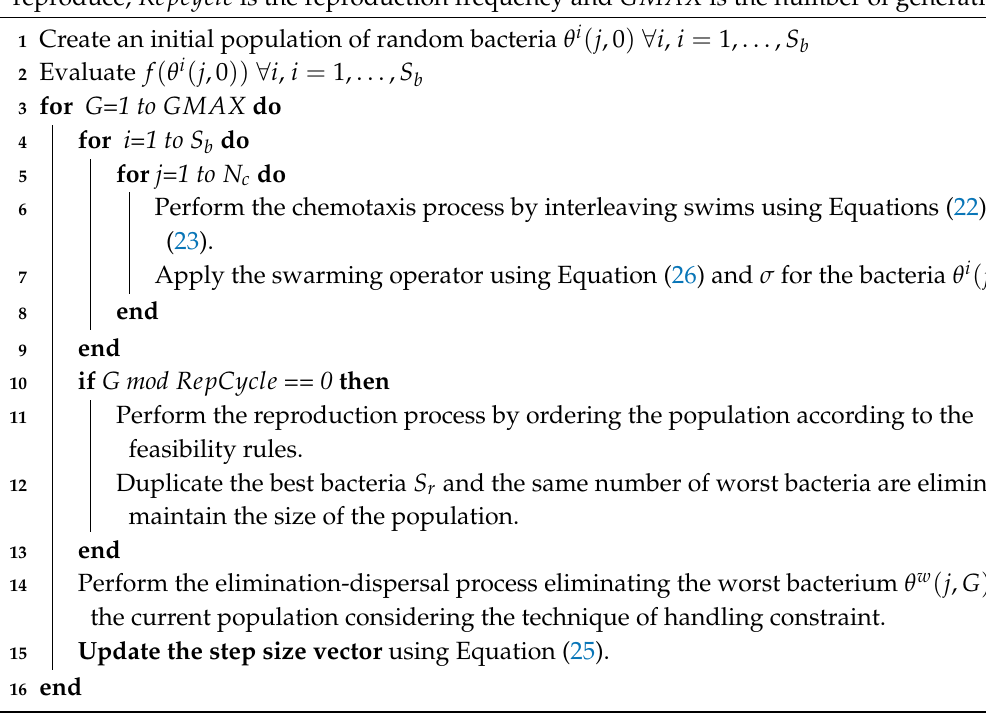
Algorithm 1: TS-MBFOA pseudocode. S b is the number of bacteria, N c is the number of chemotaxis cycles, σ is the scaling factor, R is the stepsize, S r is the number of bacteria to reproduce, Repcycle is the reproduction frequency and GMAX is the number of